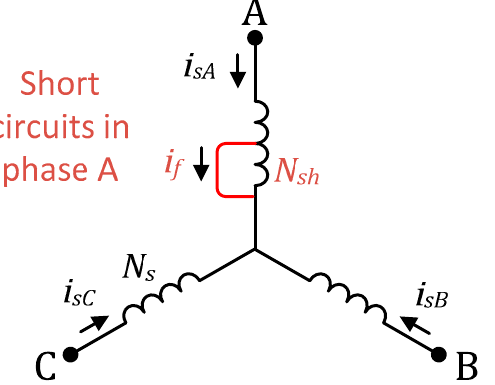
Figure 1. Schematic diagram of induction motor (IM) stator windings with short circuits in phase A.